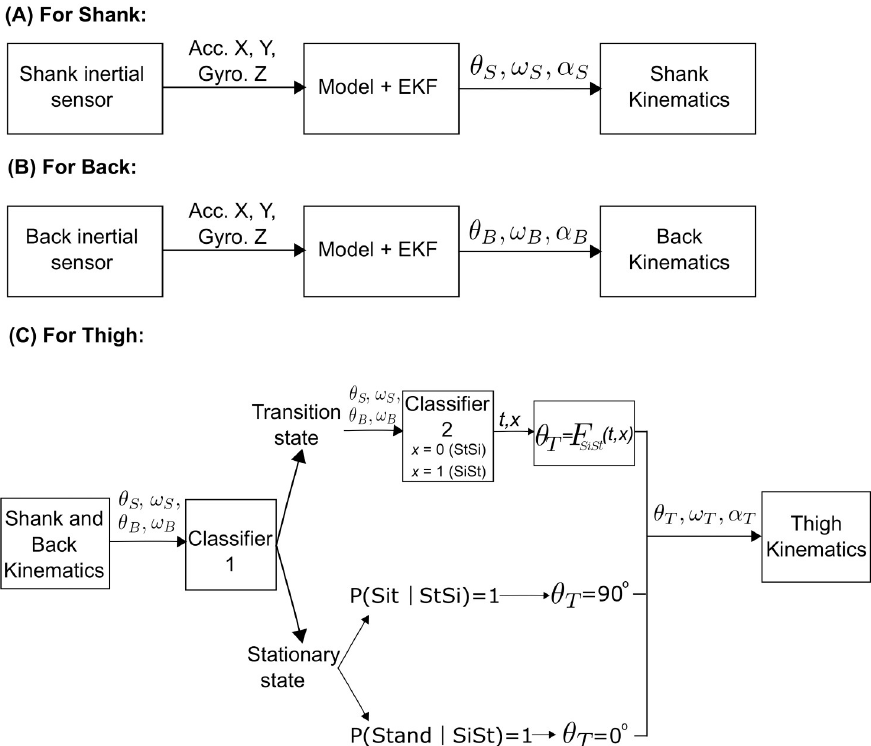
Fig 2. Processing steps for estimation of shank, back and thigh kinematics. (A) Shank kinematics estimation process using the model and EKF. (B) Back kinematics estimation process using the model and EKF. (C) Thigh kinematics estimation process by integrating the results of (A) and (B) and two-tiered classification scheme to segment and identify sit-to-stand (SiSt), stand-to-sit (StSi), sitting and standing states.